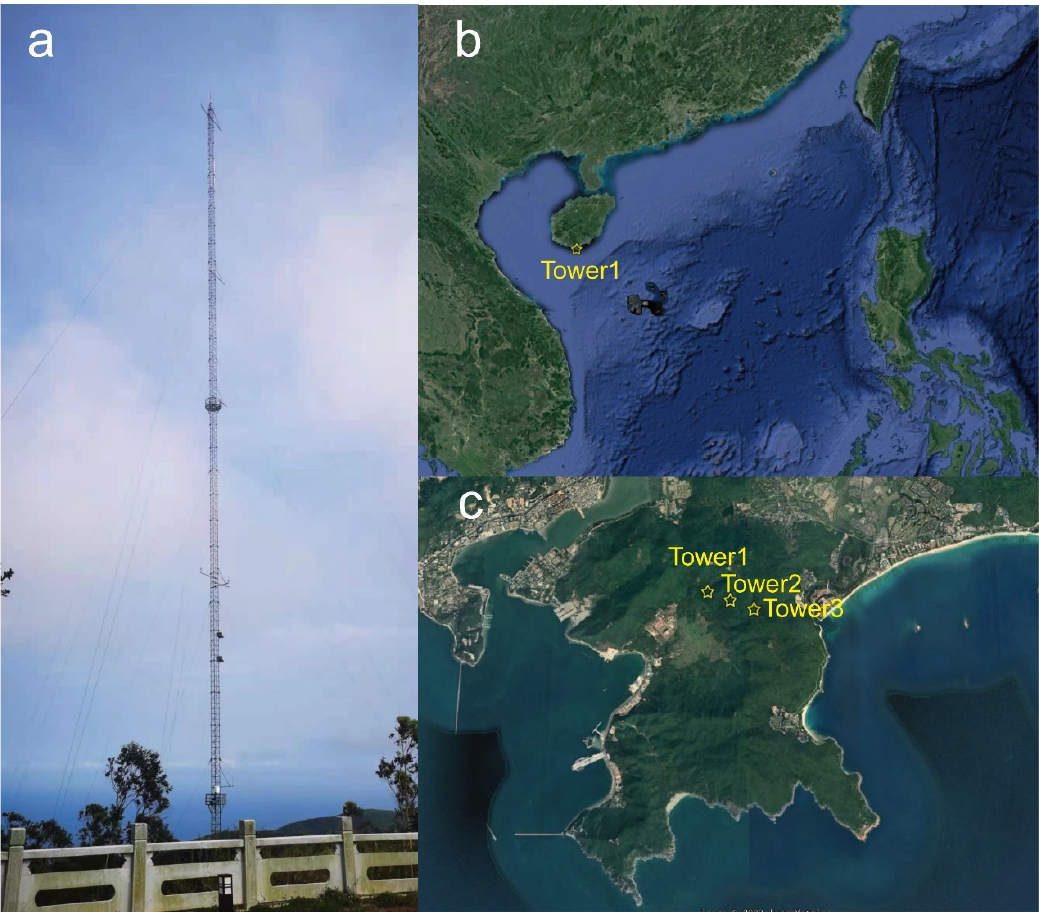
Figure 1. ( a ) Tower 1; ( b ) The location of measurement sites; ( c ) The location of the towers.